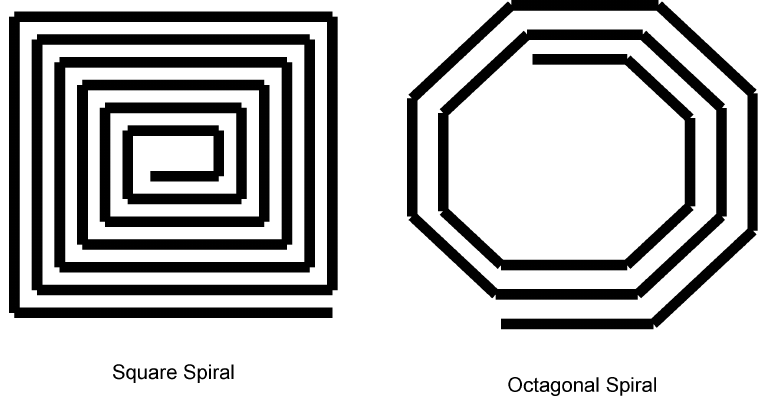
FIGURE 2 Common planar spiral structures.